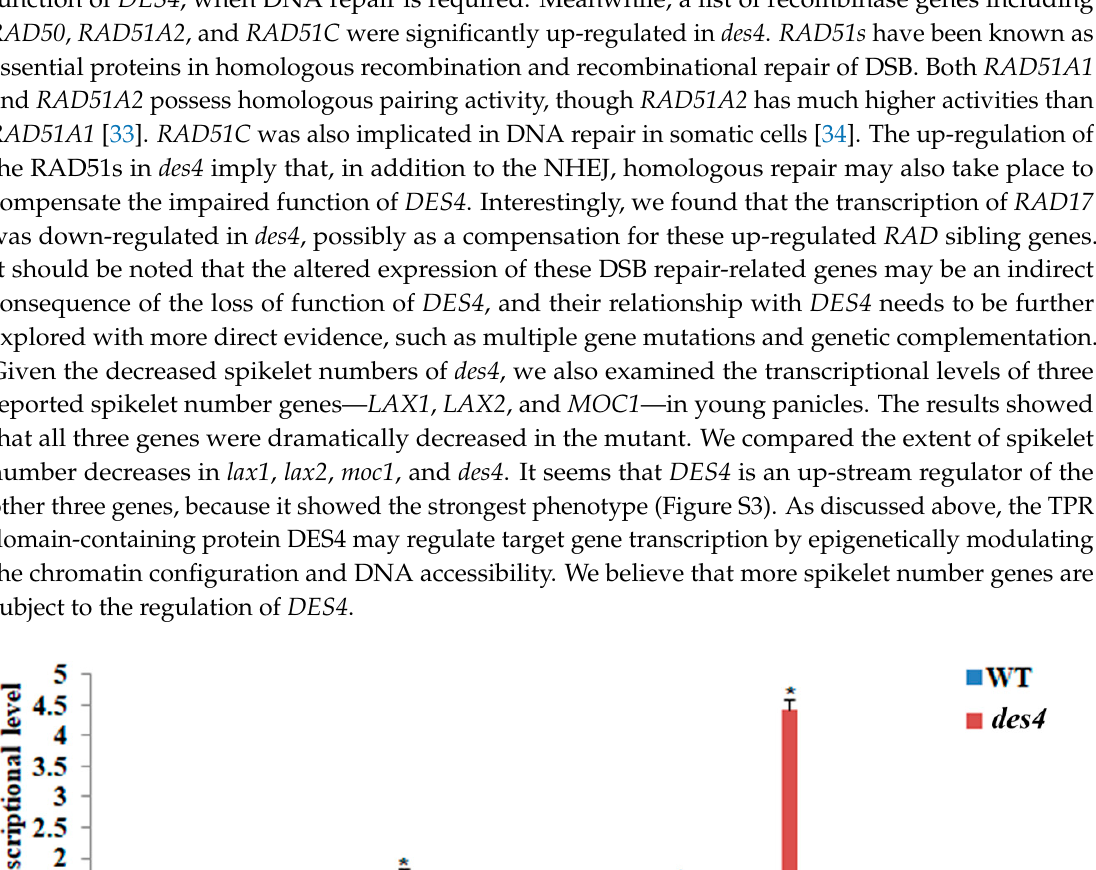
study. Figure S1: The spikelet numbers of genetically complemented des4 lines. Figure S2: qRT-PCR analysis of DES4 in various rice tissues. Figure S3: Panicle morphologies of lax1 , lax2 , moc1 , and des4 . Figure S3: Panicle morphologies of lax1 , lax2 , moc1 , and des4